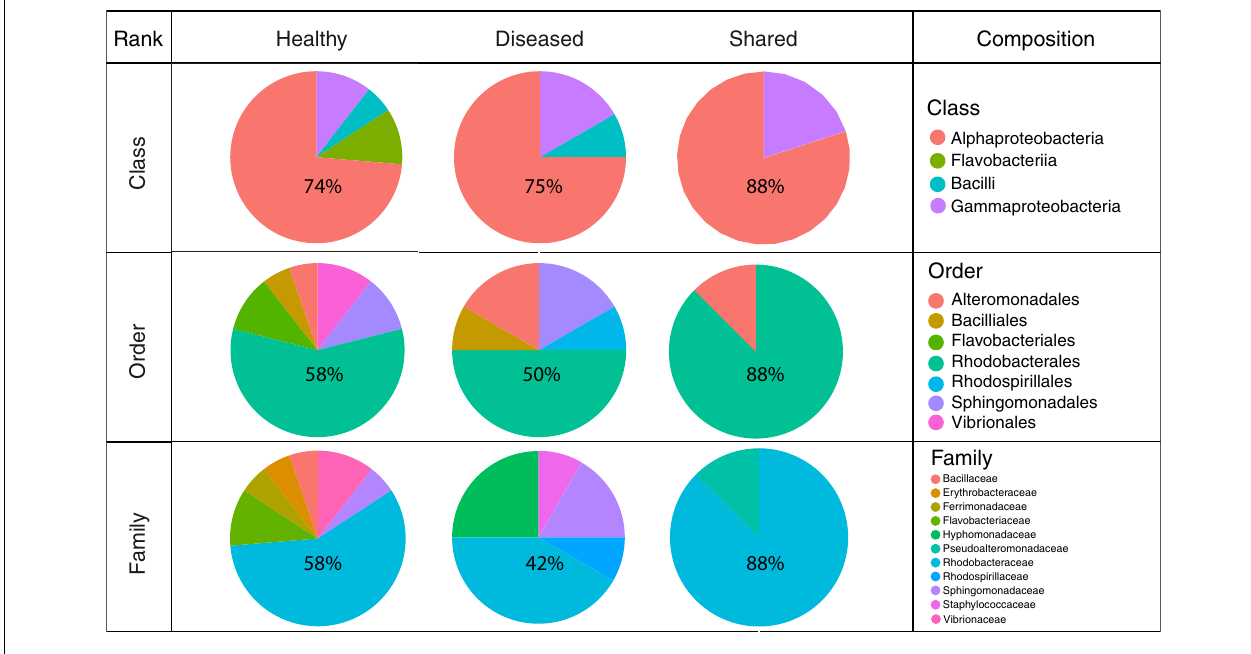
Frontiers in Microbiology |